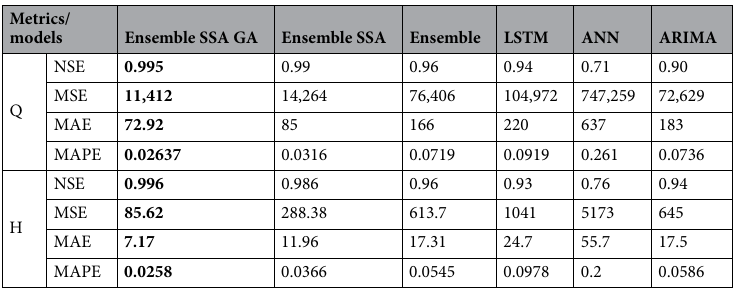
Table 7. One-step-ahead forecasting for Son Tay dataset. Best results are highlighted in bold text. Our proposed method (i.e., Ensemble SSA GA outperforms the others.